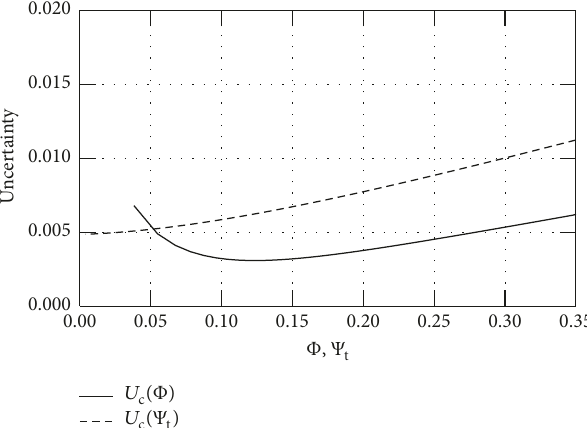
Figure 5: Expanded combined uncertainties of flow rate and total fan pressure coefficients (95% level of